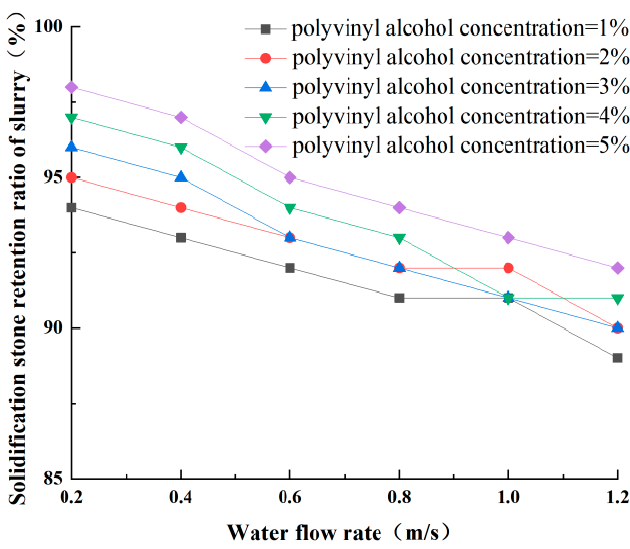
Figure 10. Effect of water flow rate on slurry solidification ratio.